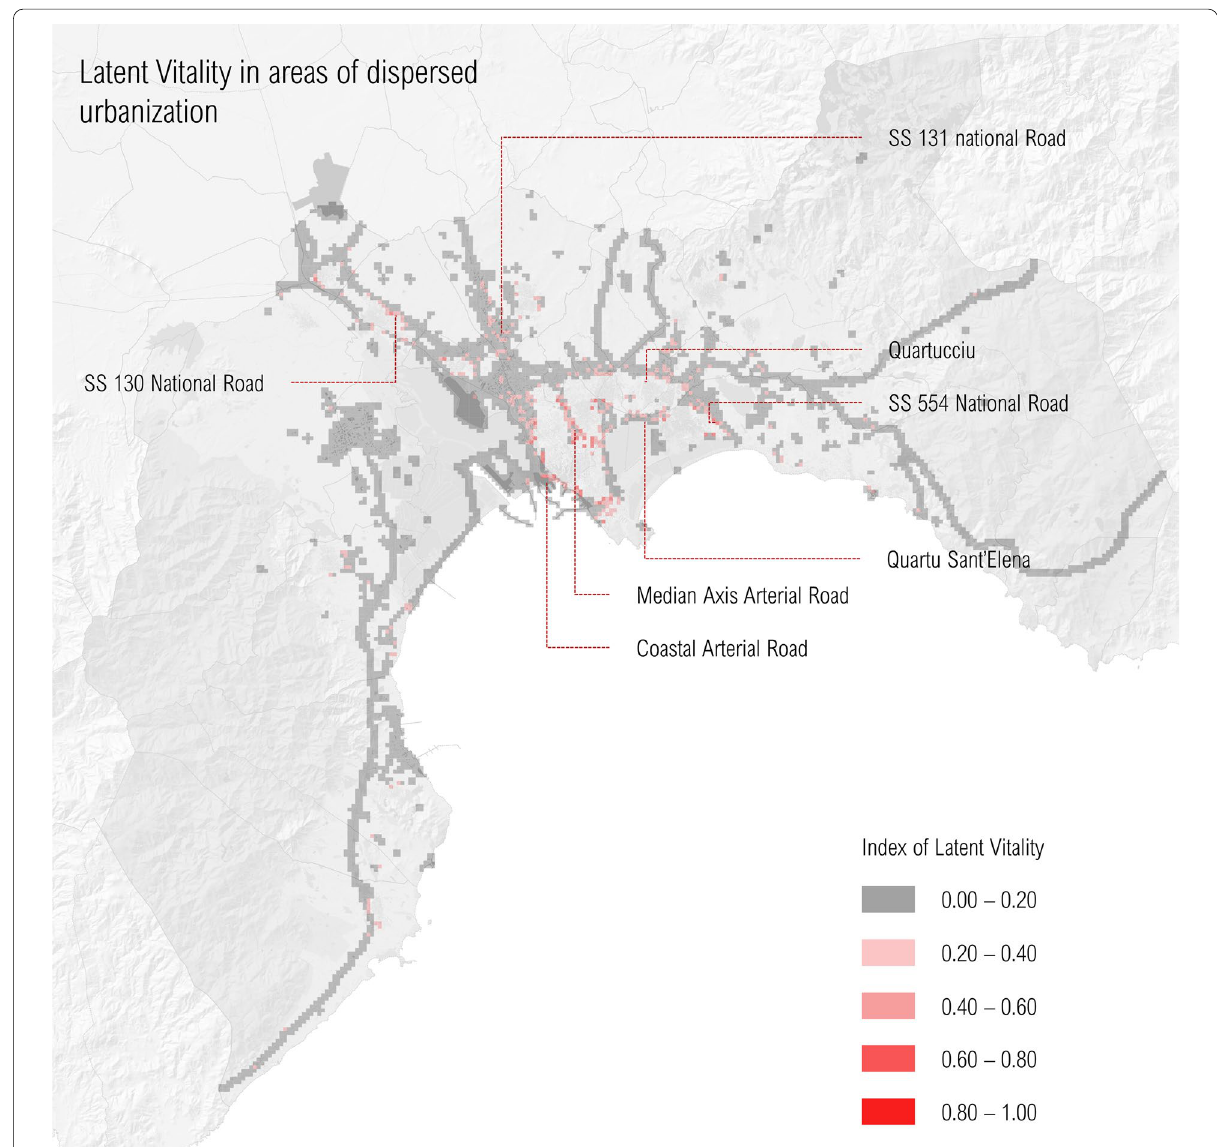
Fig. 6 Distribution of the values of the Synthetic Index of Latent Vitality (I_VIBE) across the areas of dispersed urbanization in the Metropolitan City of